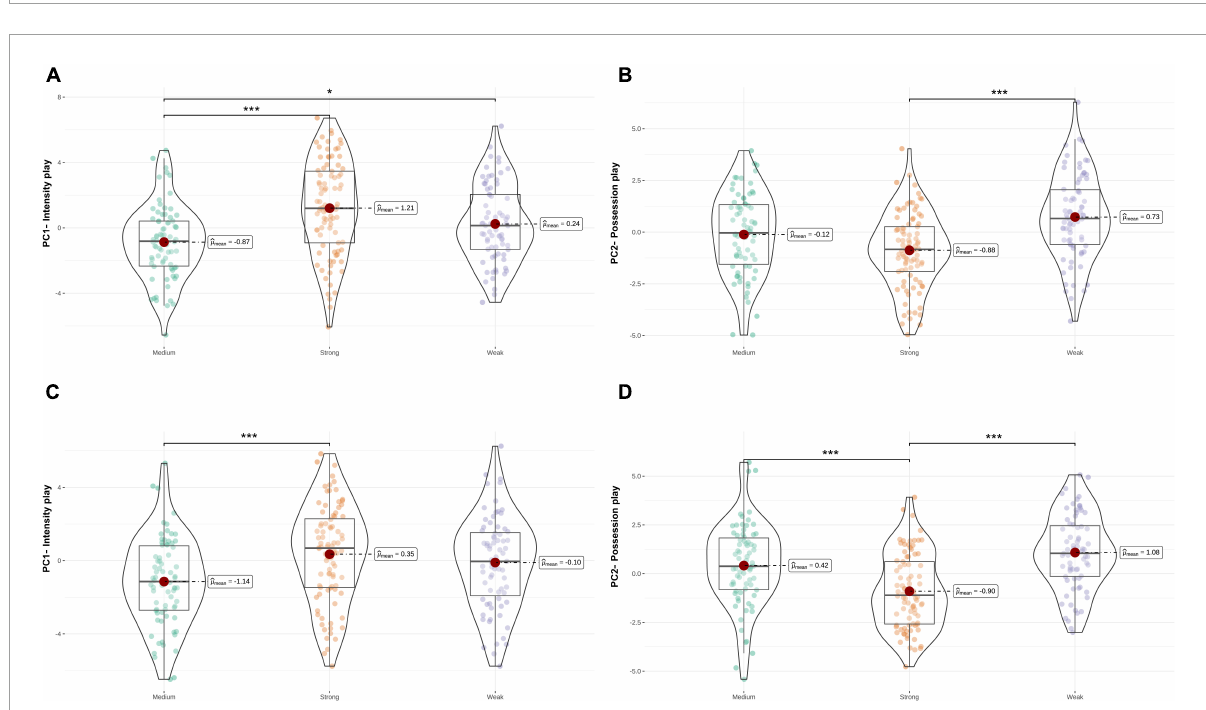
FIGURE2 The differences among three levels of teams for both PCs at home (A,B) and away matches (C,D) .